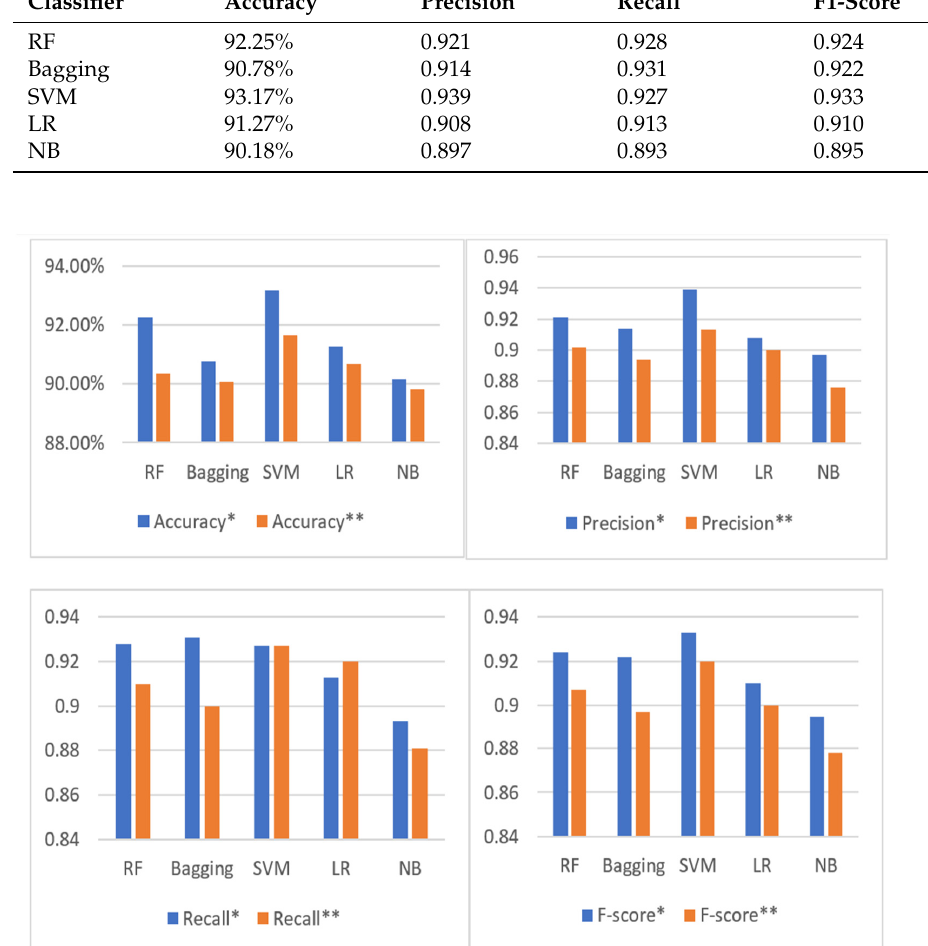
Figure 9. Performance of ML models with TextBlob sentiment and the concatenated features + lexicons: * denotes that TextBlob sentiment is used with the concatenated features extracted by the word representation techniques; ** TextBlob sentiment is used with concatenated features + lexicons.